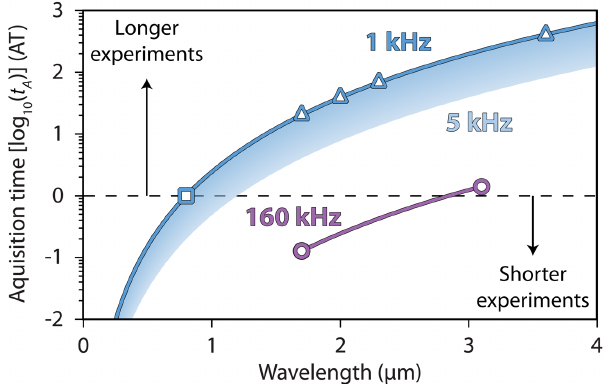
FIG. 8. The number of “ acquisition times ” (as defined in the text) required for a range of driving wavelengths after accounting for the λ − 4 scaling of electron rescattering. Typical 1-kHz systems based on Ti:sapphire technology (Ref. [11], blue triangles) are limited as total acquisition times become untenable. Even the expected repetition rate upper limit of 5 kHz is not fast enough to compensate for the decrease of signal (shaded region). Using a 160-kHz system such as our OPCPA, on the other hand, allows much shorter acquisition times (purple